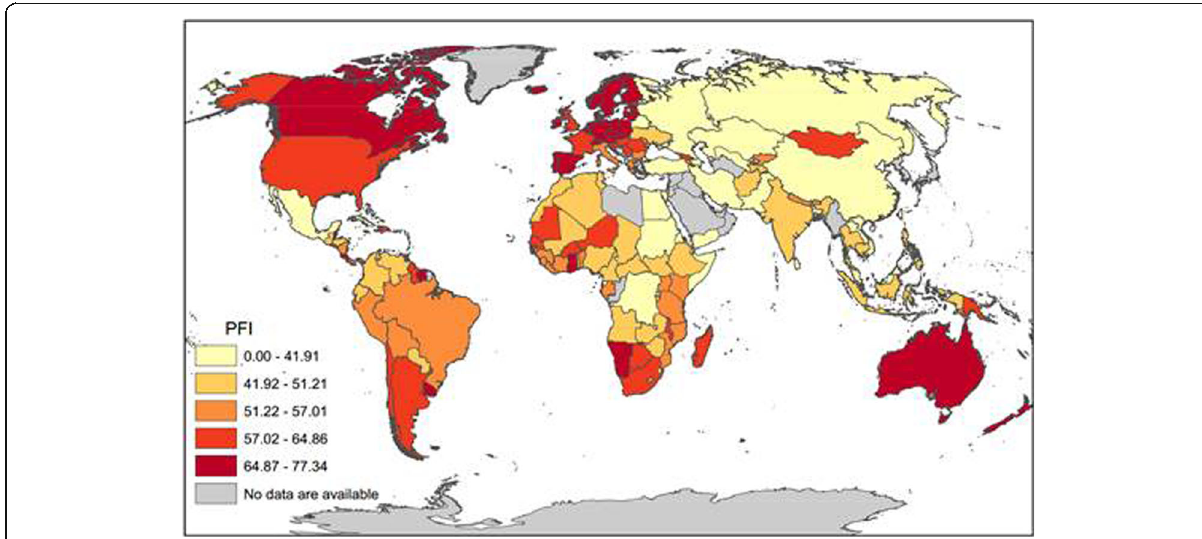
Fig. 2 2015 Global pattern of Press Freedom Index with larger numbers indicating higher levels of press freedom (Source: Created using data from the Reporters Without